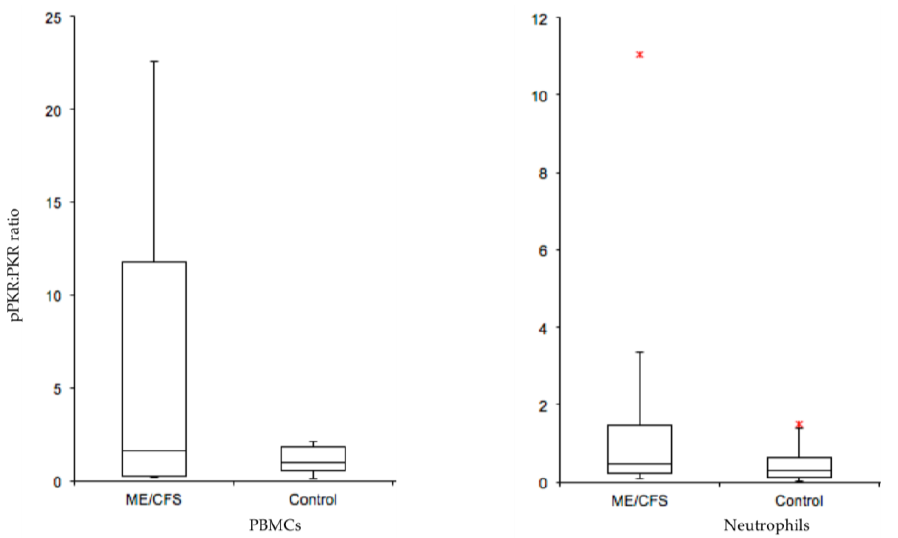
Figure 2. Box-and-whisker plots of ME/CFS and control phosphorylated PKR/protein kinase RNA-activated (pPKR:PKR) ratios in PBMCs and neutrophils. In-house affinity purified antibodies against phosphorylated PKR (active form) and PKR (inactive form) were used to detect the ratio of pPKR:PKR in isolated PBMCs and neutrophils from a matched patient/control ME/CFS study. The median pPKR:PKR ratio is shown, and the interquartile range, maximum and minimum ratio values. Outliers are indicated with a (*). A t-test between ME/CFS and controls gave a P-value of 0.057 in PBMCs (ME/CFS n = 9, controls n = 9) and 0.142 in Neutrophils (ME/CFS n = 9, controls n = 10). This figure has